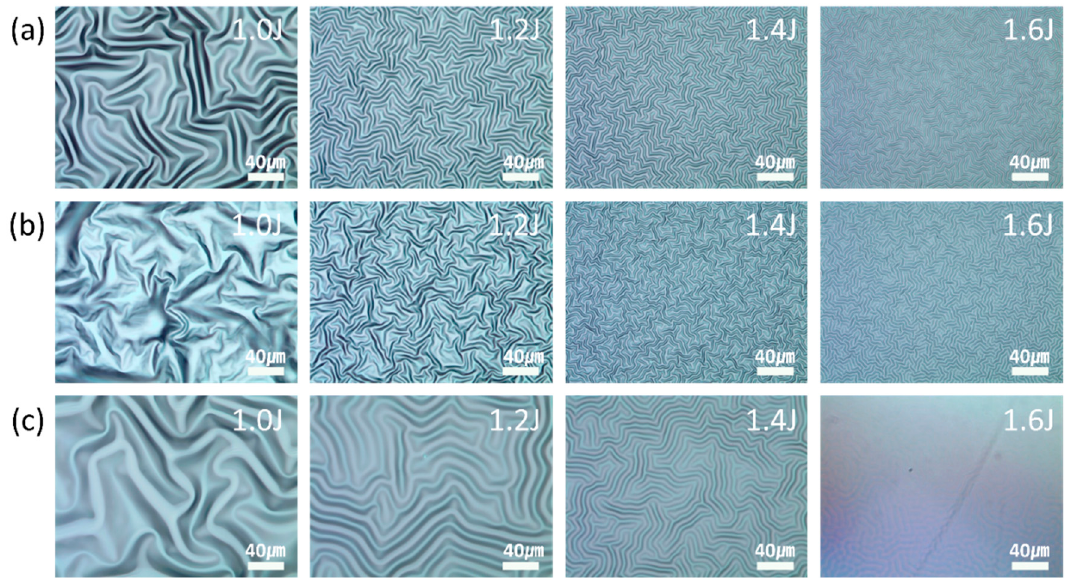
Figure 4. Optical microscopy (OM) images of the various wrinkles that were generated on the ultraviolet (UV)-curable optical adhesive (Norland Optical Adhesive 63; NOA63) at different magnitudes of the first curing energy after ( a ) nitrogen, ( b ) oxygen, and ( c ) argon plasma treatments.